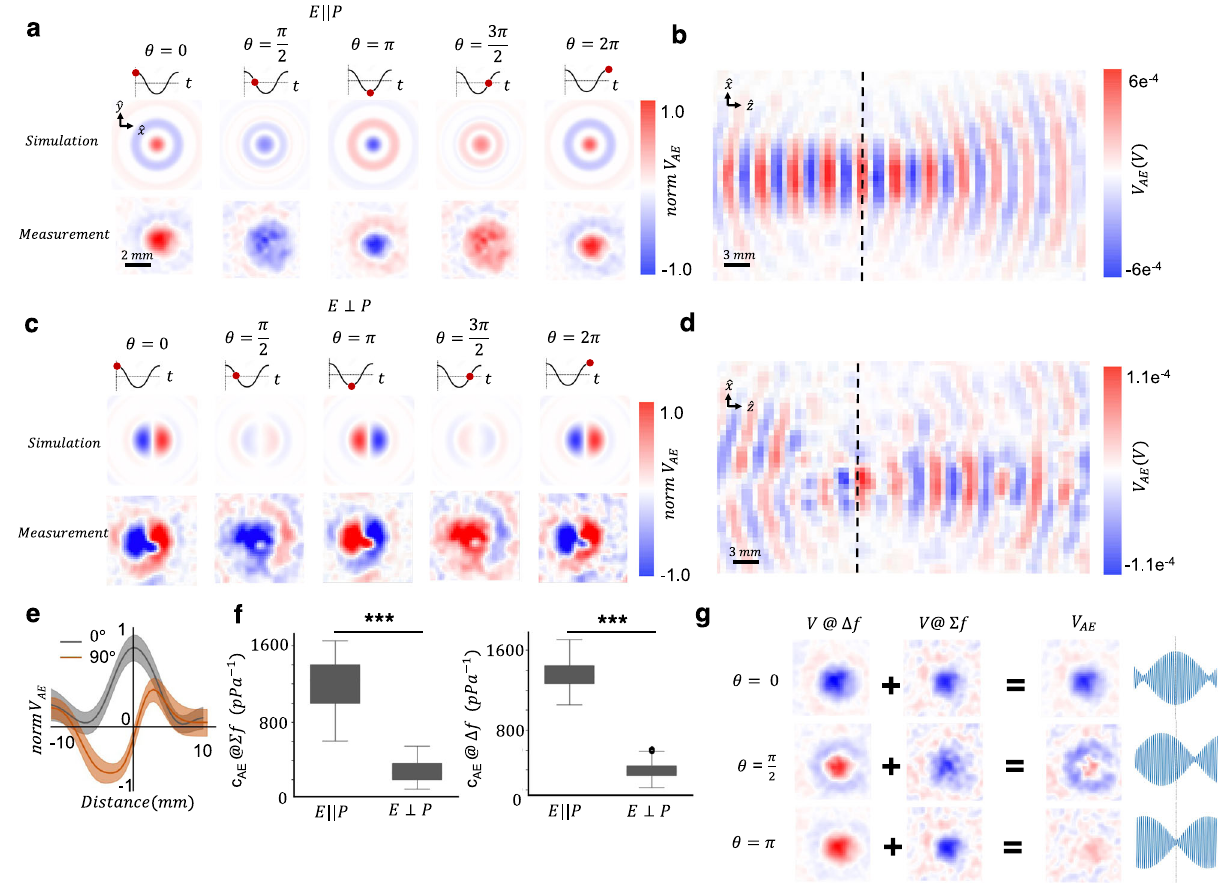
Fig. 4 Measurements of acoustoelectric fi elds ’ spatiotemporal characteristics in a physiological phantom. Spatiotemporal characteristics of the electric fi eld generated by simultaneous application of a focal acoustic pressure fi eld P ( x,y,z ) at a frequency f = 500 kHz propagating in the ^ z direction and an ! A ð x ; y ; z Þ at a frequency f = 8 kHz. Measurement setup same as in Fig. 3a, but with the measurement probe scanned across the volume. electric fi eld E E potential V AE (normalized to max value) in the radial plane ^ x ^ y at the black dashed line in ( b ) shown at different phases θ of the acoustic period (1 = f A ), electric fi eld is perpendicular to the propagation direction ^ z of the applied acoustic fi eld, shown are as in ( a ) and ( b ). e Line plot comparing the measured electric potential V AE normalized to max value along the black dashed lines in ( b ) and ( d ). f Acoustoelectric coupling factor at the sum frequency ∑ f ,